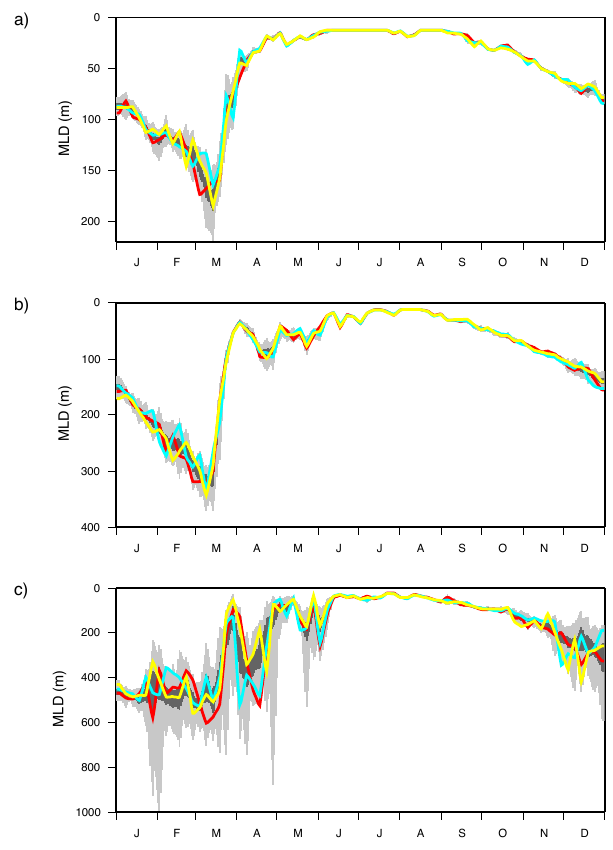
Fig. 2. Illustration of 100 member mixed layer depth ensemble at (a) BATS, (b) NABE and (c) OWS-INDIA sites, showing full ranges (light grey), inter-quartile ranges (dark grey) and three ex- ample members (coloured).